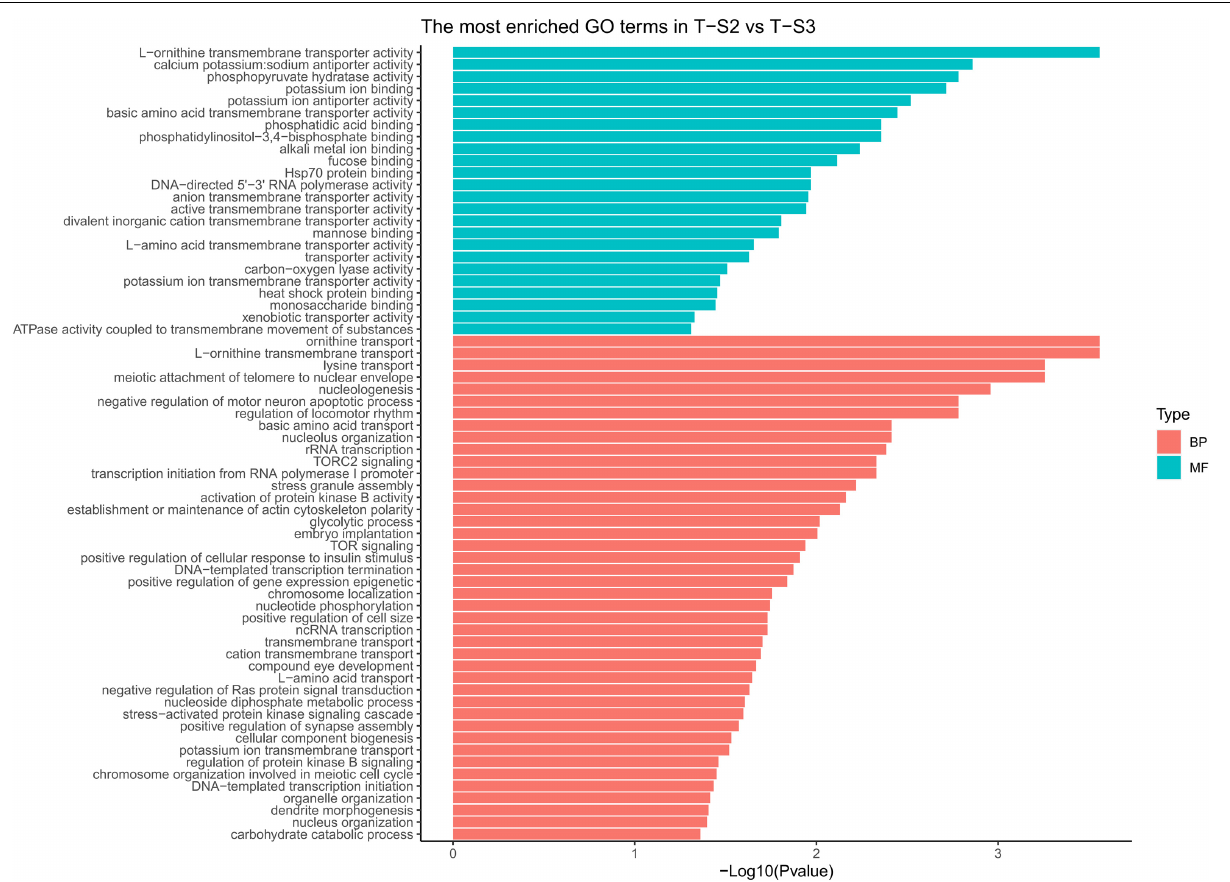
oysters to enhance their color and quality as donors is